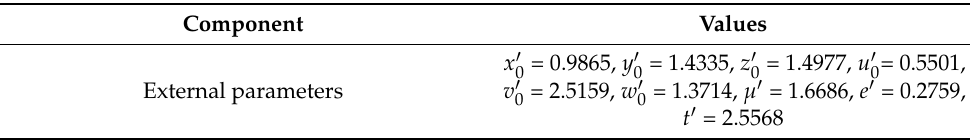
Figure 10. Plain images: ( a ) 8BPP Lena; ( b ) 16BPP Lena; ( c ) 24BPP Baboon. Table 11. The external